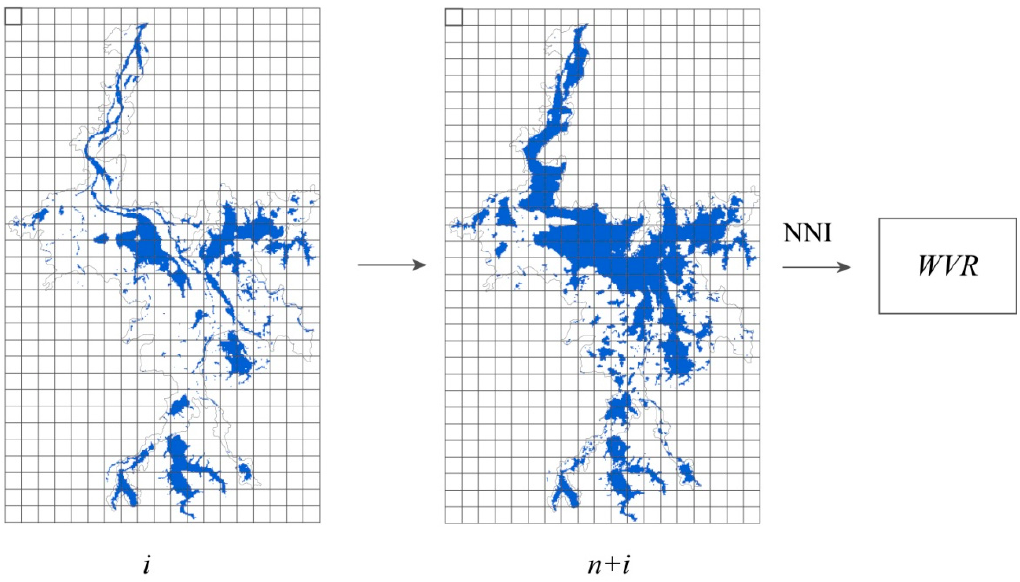
Figure 2. A sketch of the methodology used to derive the WVR.